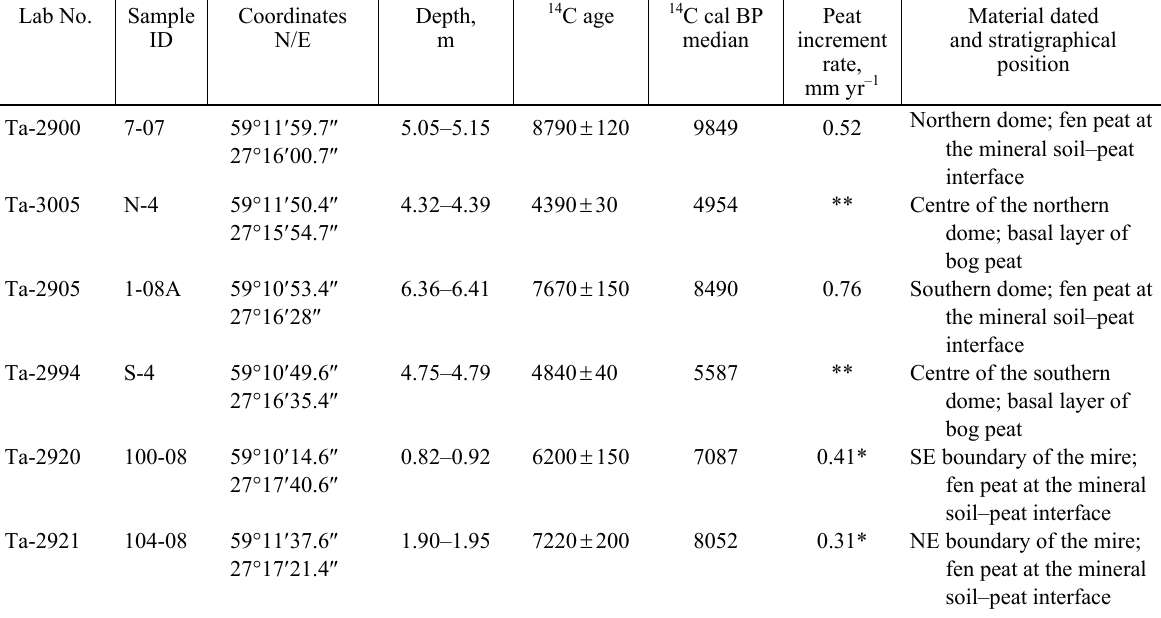
Table 1. Bulk radiocarbon dates and calculated increment rate of peat in the Selisoo mire. For sampling locations see Fig. 2 Lab